Question: How would you classify this visualization?
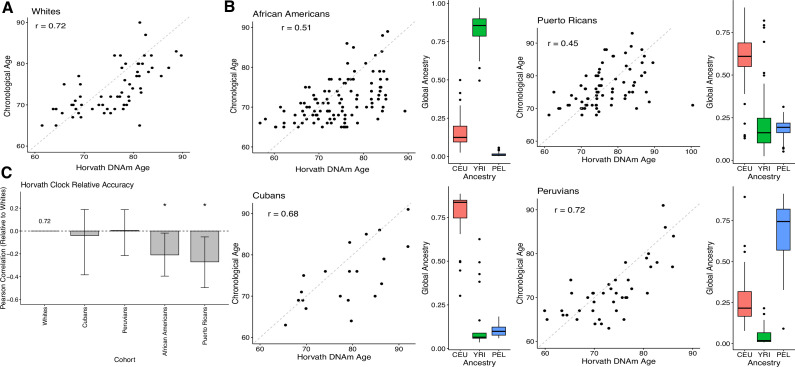
Answer: box